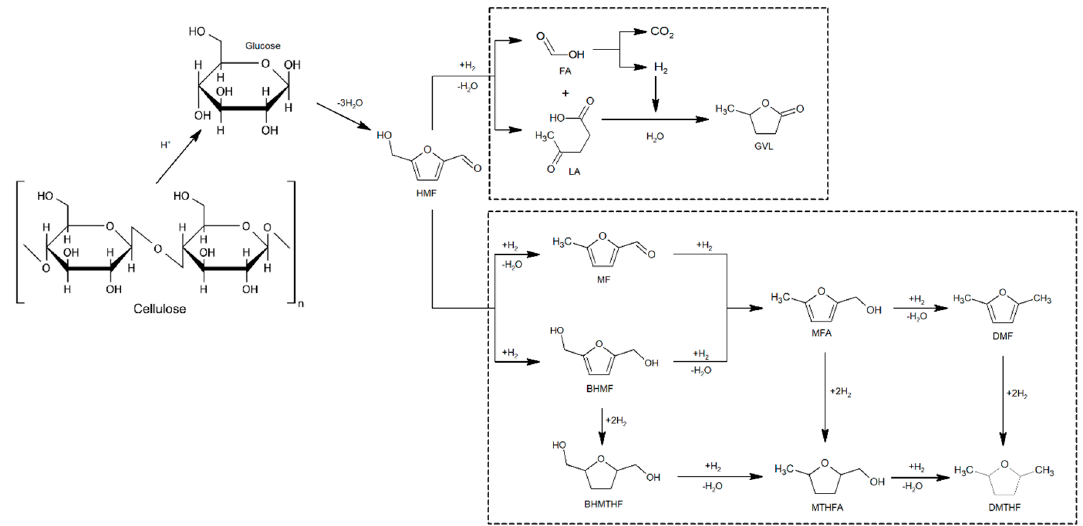
Scheme 1. Reaction pathways of the HMF hydrodeoxygenation with the possible formed products and of the LA hydrogenation into γ -valerolactone (GVL) with formic acid (FA) as an internal hydrogen source, in the context of the global valorization of cellulose through initial hydrolytic hydrogenation.